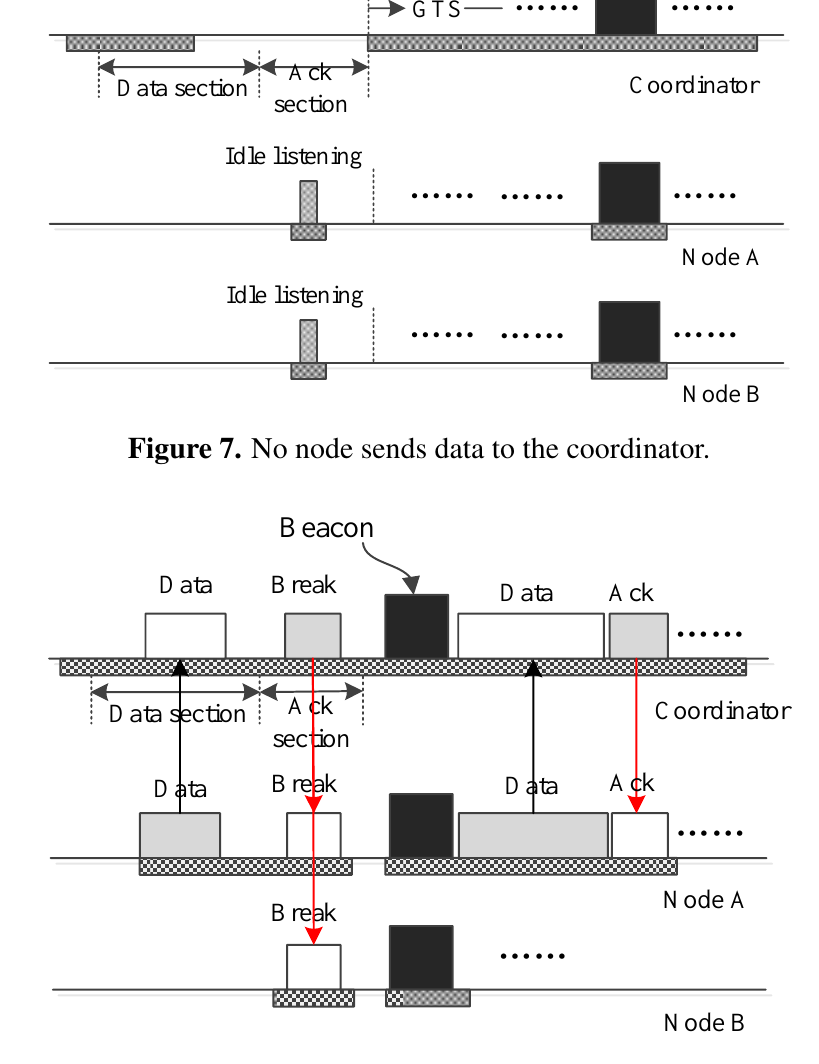
Figure 8. Only one node sends big data to the